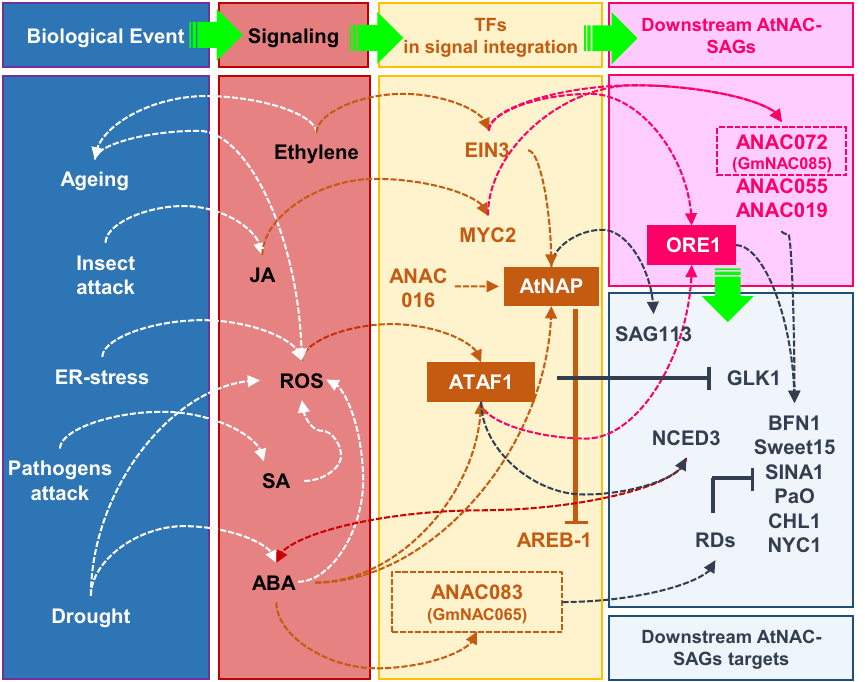
Figure 10. Schematic representation of the gene regulatory network coordinated by environmental stimuli, plant hormones, and AtNAC-SAGs. The different environmental stimuli culminate in plant hormone signaling, which activates several SAGs in response to multiple stresses. Consequently, the expression of these SAGs triggers an age- or -environmental cell death. GmNAC085 up-regulates ATAF1 , ORE1, and AtNAP , involved in integrating ABA, age, and ROS signals. Increased expression of these genes results in the activation of several downstream SAGs involved in the degradation of chlorophyll and other pigments, which confer accentuated senescence phenotype. Contrastingly, the expression of these genes is attenuated by GmNAC065 leading to a better plant performance under multiple stresses and a delayed senescence phenotype. Adjusted from Bengoa- Luoni et al. 2